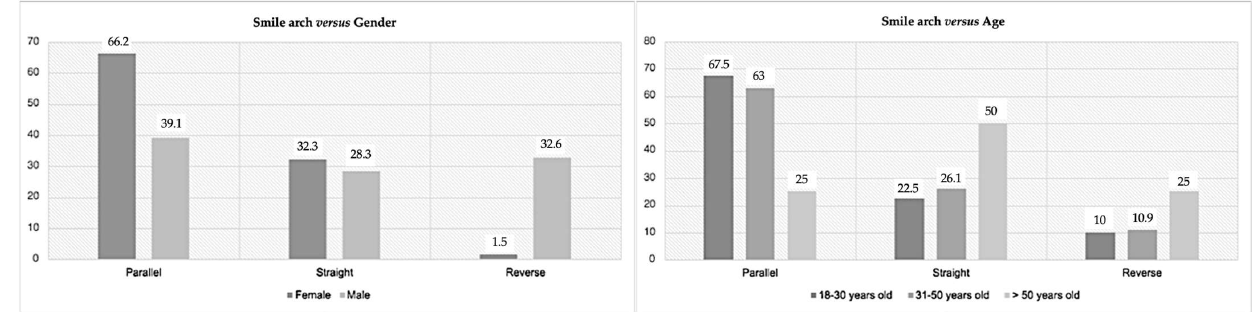
Figure 4. Prevalence of the smile arch according to gender ( left ) and age ( right ).